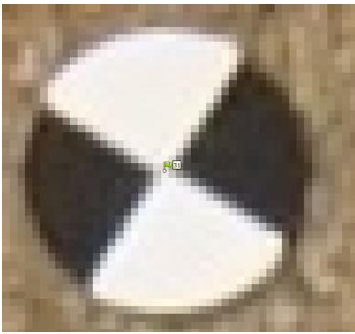
Figure 2. Ground control target as it appears in